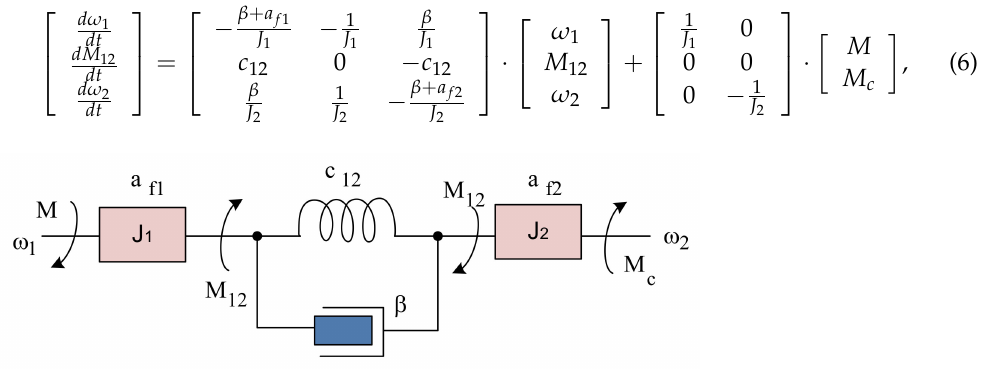
Figure 4. Block diagram of a two-mass